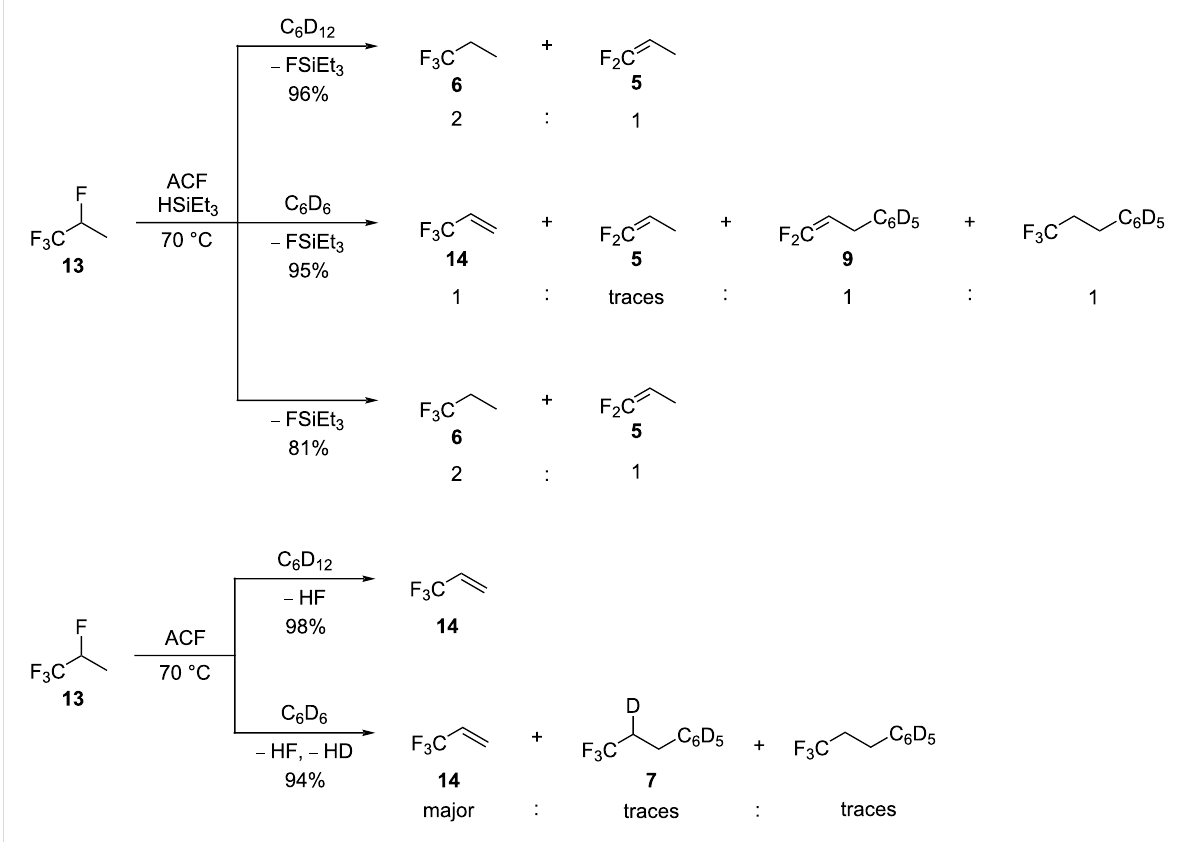
Scheme 6: Reactivity of 13 in the presence of ACF as the catalyst, with (top) or without (bottom) HSiEt 3 as a hydrogen source.